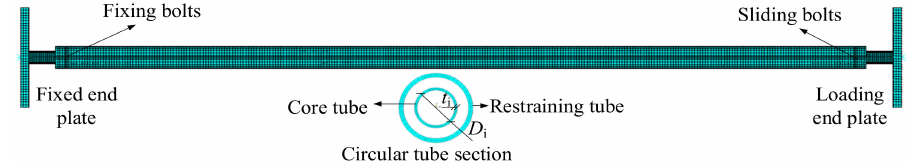
Figure 13. FE model in the parametric study.